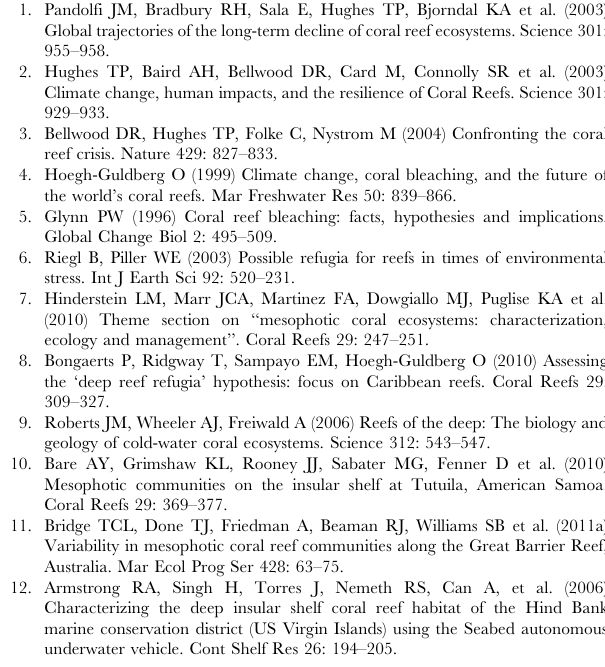
Table S1 Location and survey method of each occur-